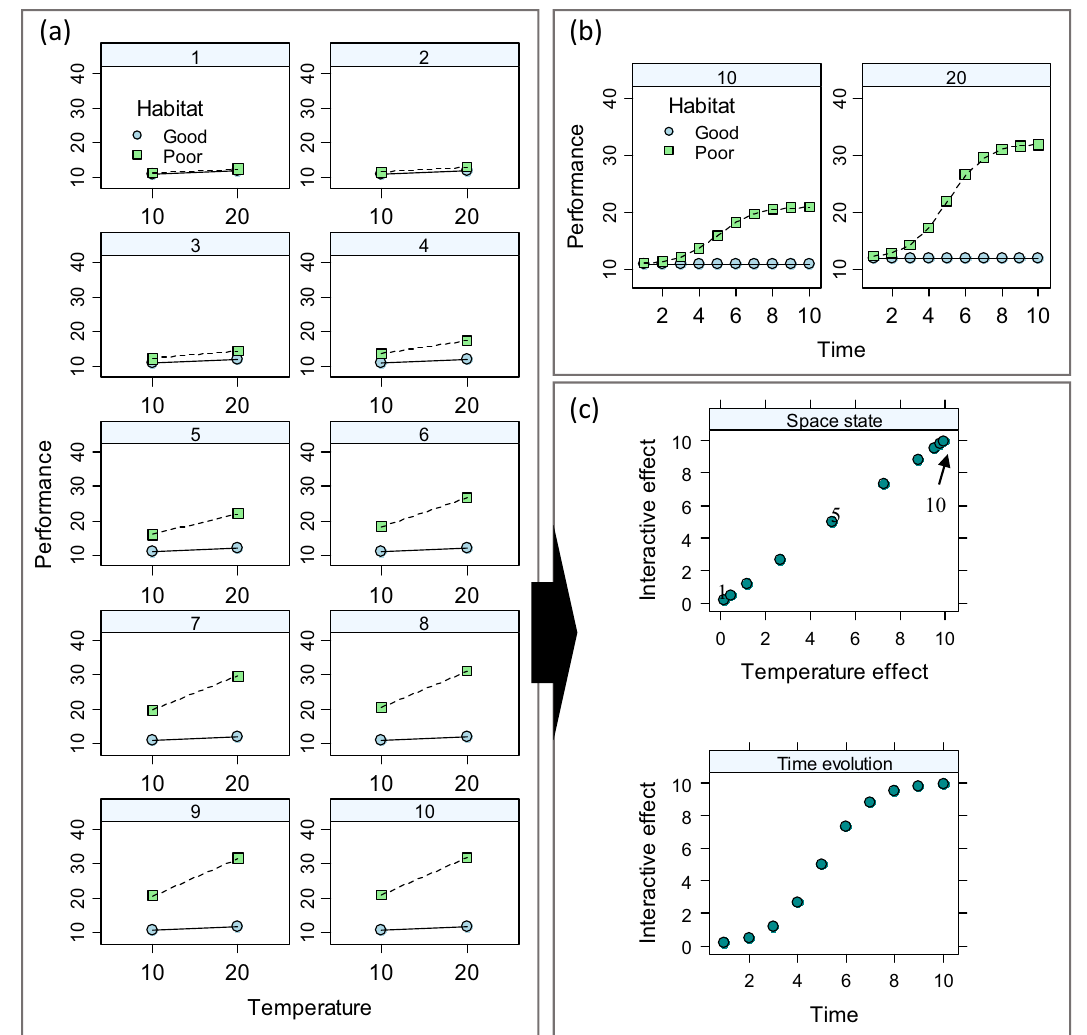
Fig. 4 Simulation of the time evolution (in arbitrary units) of a synergistic response to temperature (°C) and a second driver indicating habitat quality (e.g. food level). The control ( = best) condition is set by T = 10 °C and ‘ good habitat ’ . In the ‘ good habitat ’ , the increased temperature has a small effect on the response that remains constant through time. In the ‘ poor habitat ’ , the increased temperature has a large effect that in turn increases through time following a sigmoidal pattern. a Interaction plot for each of the 10-time units. b The same data plotted over time, with separate panels for each temperature level: notice how the response in the ‘ good habitat ’ changes through time following the sigmoidal pattern. c State-space representation: upper panel: 2D plot of the interactive effect and the effect of temperature alone for each time point (time points 1, 5 and 10 are indicated); in the example, the effect